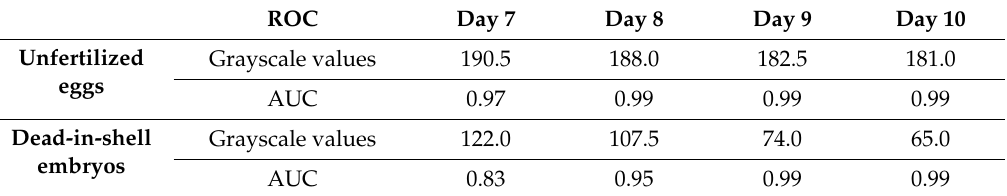
Figure 4. Change in grayscale values of fertilized eggs, unfertilized eggs, and dead-in-shell eggs. Table 2. ROC analysis results.